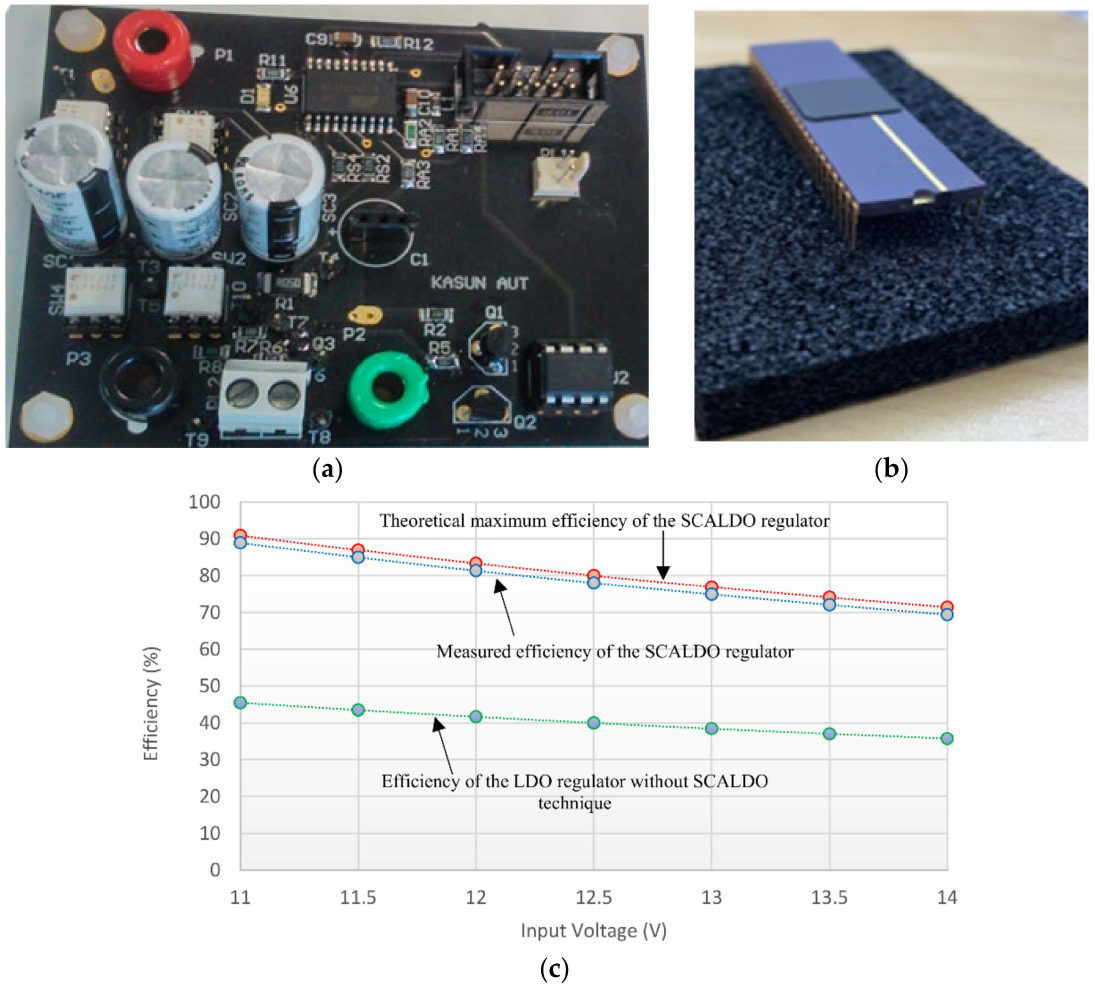
Figure 12. ( a ) SCALDO 12 V–5 V discrete prototype [5]; ( b ) SCALDO IC; ( c ) comparison of end-to-end efficiency of the 12–5 V SCALDO